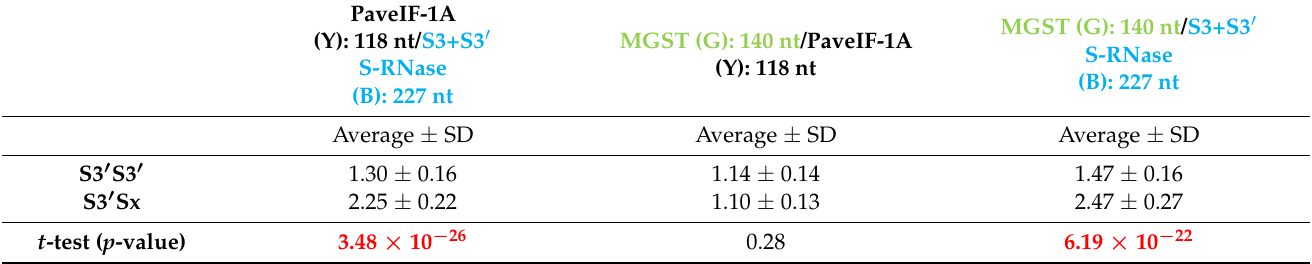
Table 5. A comparison of S3 (cid:48) S3 (cid:48) and S3 (cid:48) Sx genotypes. Ratios of respective peak heights were calculated and compared. MGST with only one allele present was used in parallel to show no significant difference between the amplification of the two control genes in both groups. The letter in parentheses indicates the channel a specific peak is detected in Y yellow (represented here by black for contrast); B blue; G green. SD: standard